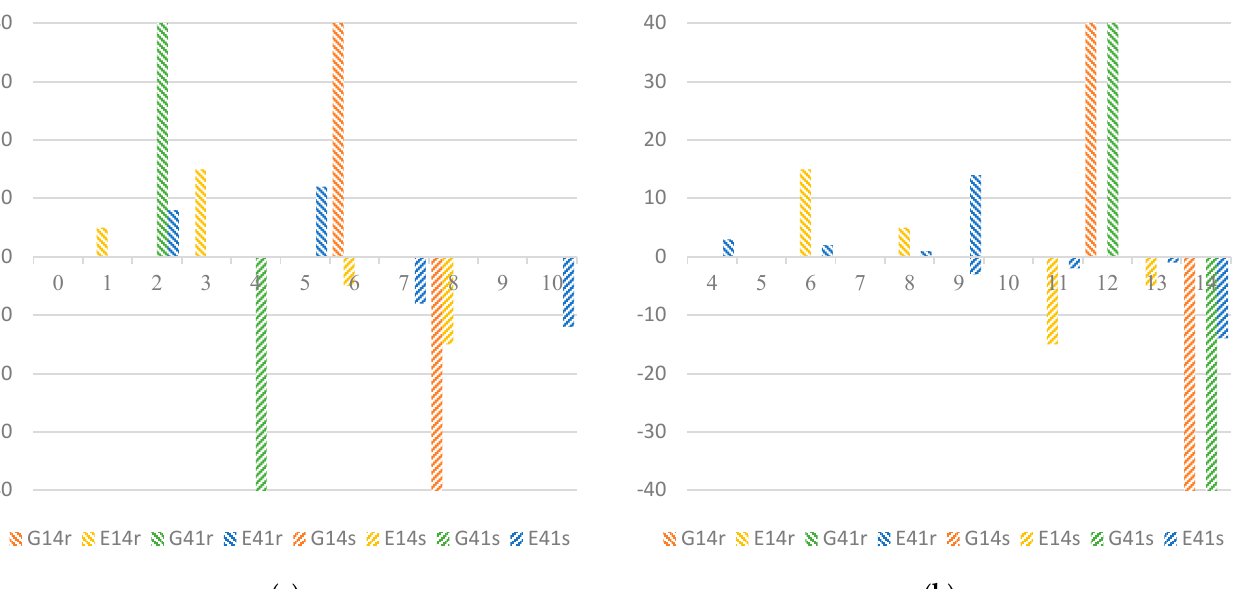
Figure 12. Path assignment of EVs of 2 tasks h (PDN prior, T = 14).